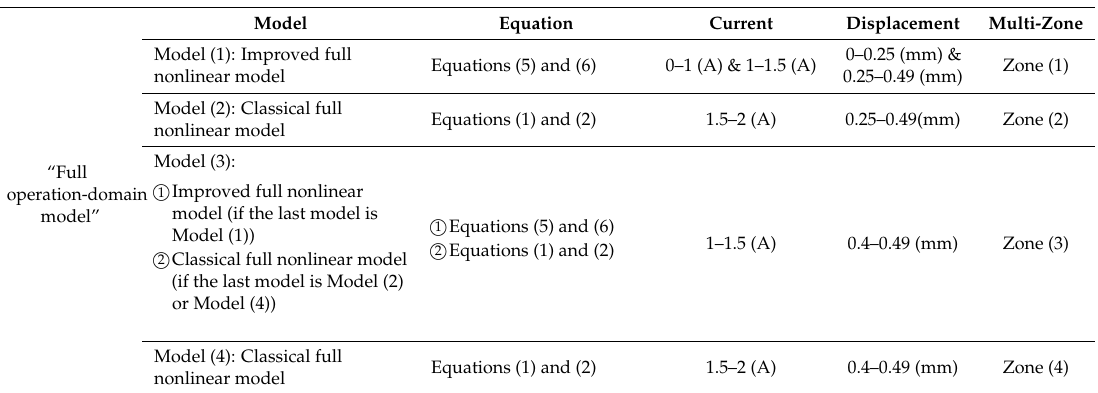
Table 1. The “switching model” across multi-zone selection